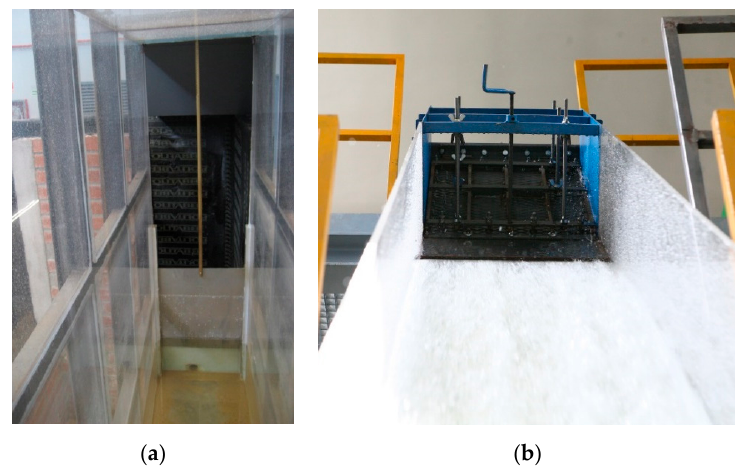
Figure 3. Initial and boundary conditions in the physical model: ( a ) Intake flow gate located at the entrance of the spillway chute; ( b ) Regulation gate to control the still basin.